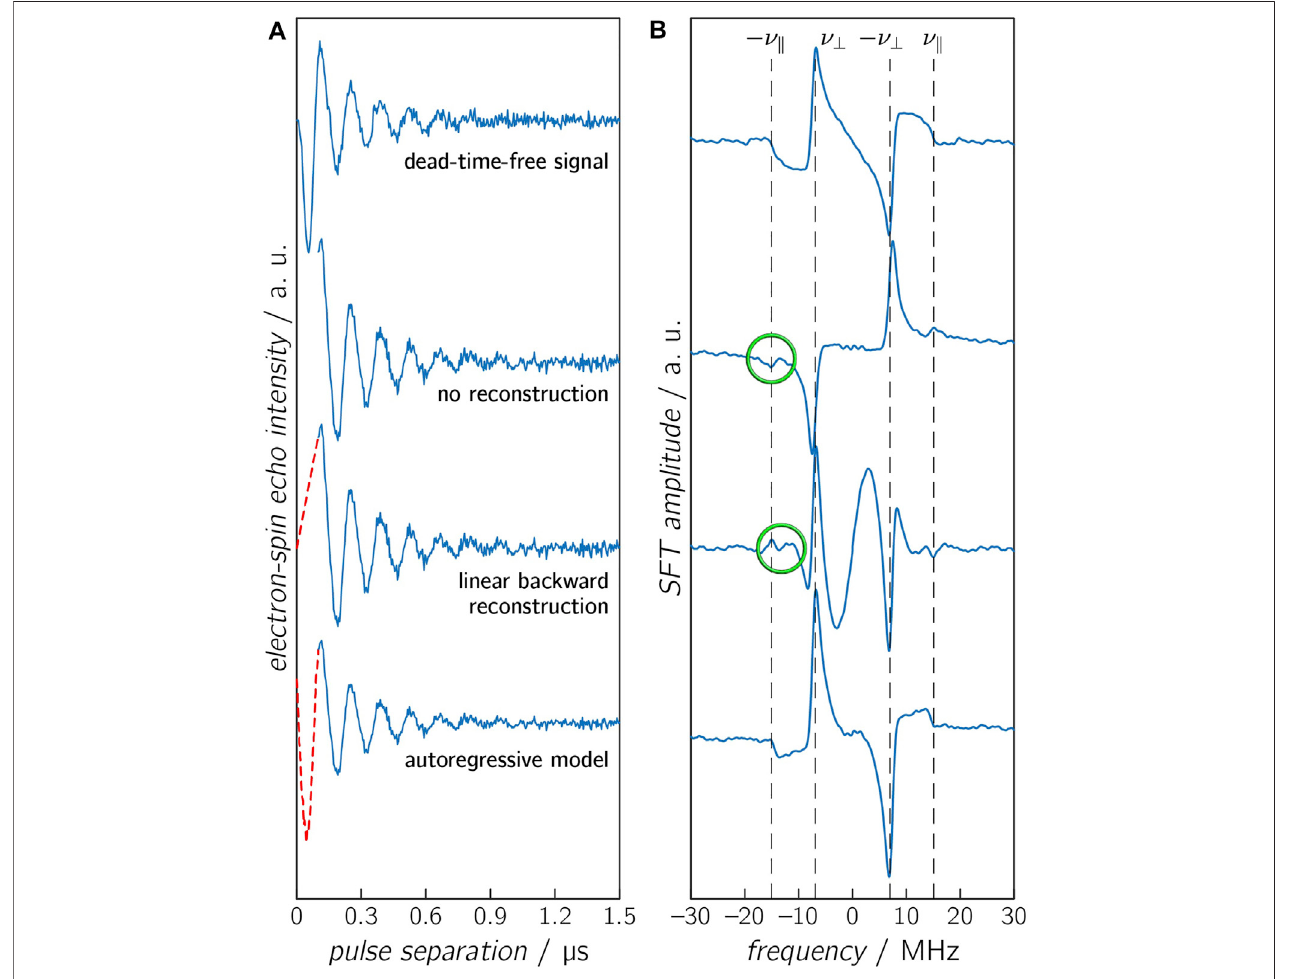
FIGURE3 | Calculated OOP-ESEEM time traces (A) ,including noise (SNR= 50) witha spectrometerdeadtime of100 ns, and the correspondingSFT spectra (B) . The missing fi rst 100 ns were either not reconstructed (second panel), reconstructed with a linear model (third panel), or reconstructed with an AR model (lowest panel). The untruncated time trace is depicted in the upper panel. The vertical dashed lines in the SFT spectra depict the frequencies ] ⊥ and ] (cid:3) . Differences between calculated and reconstructed values of ] (cid:3) are highlighted in green.